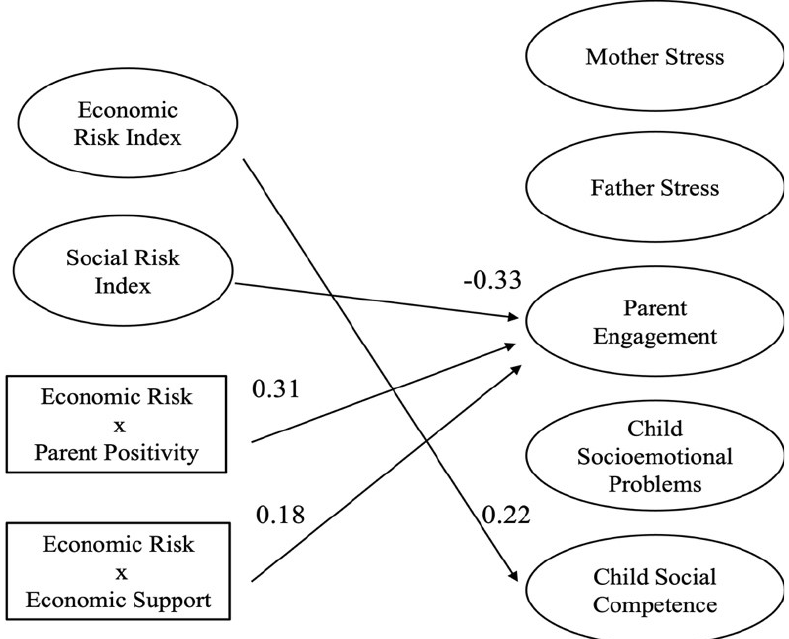
Figure 2. Associations between economic and social risks and family functioning. Note. All predictors are mean-centered. For parsimony, errors and non-significant coefficients are omitted from the figure. All standardized coefficients and covariances are significant at p < 0.05.